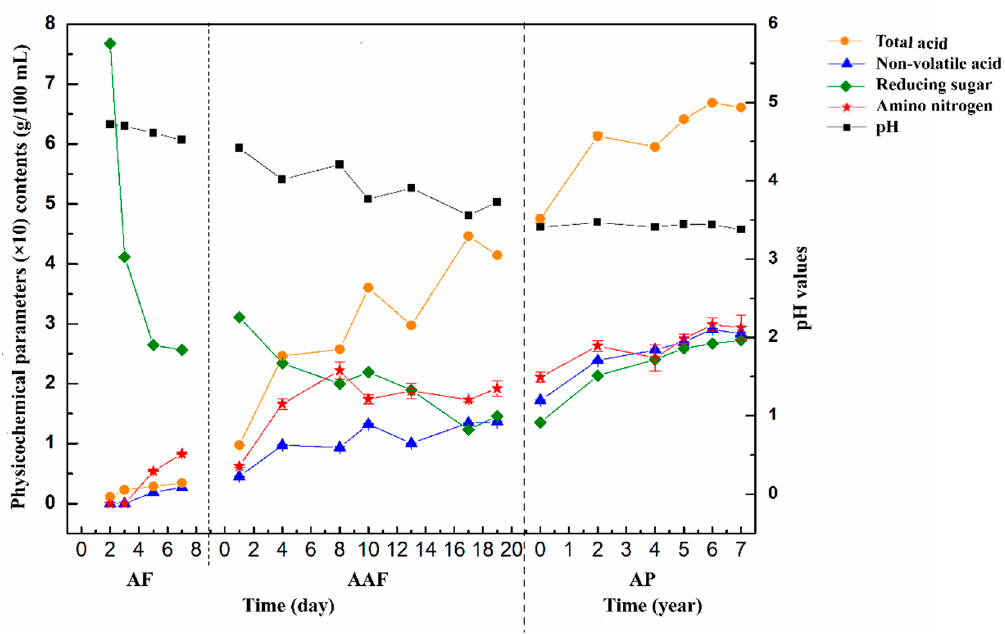
Figure 1. Changes in physicochemical parameters during the brewing process of Zhenjiang aromatic vinegar (ZAV). AF: alcohol fermentation, AAF: acetic acid fermentation, AP: aging process.